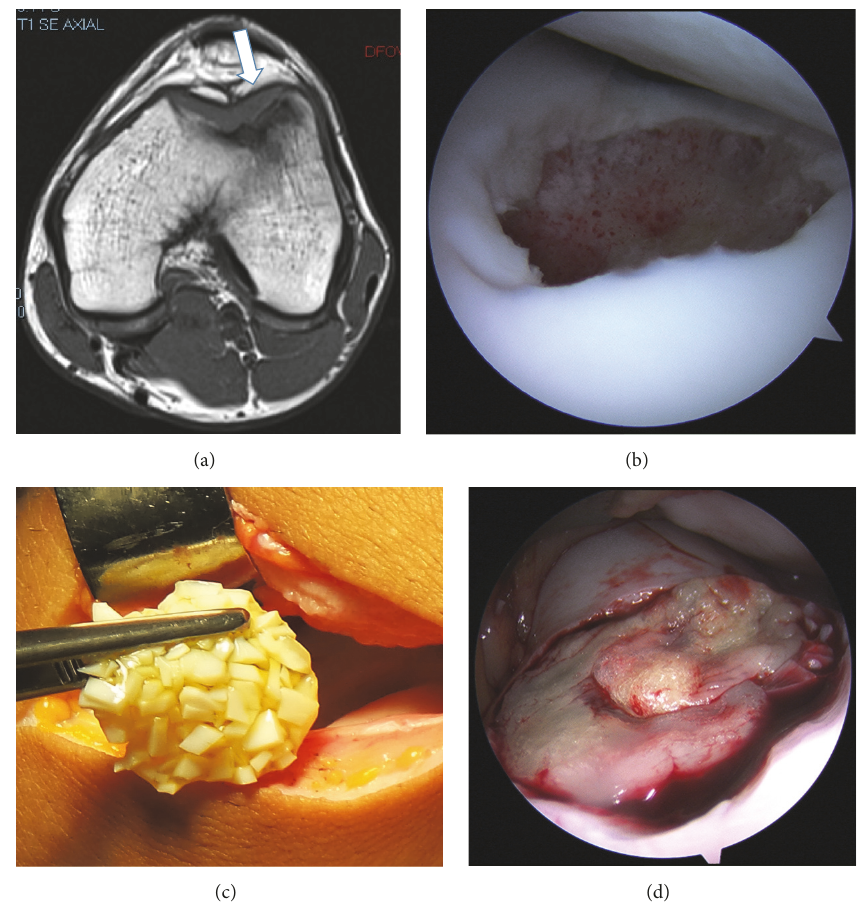
Figure 1: Composition of figures demonstrating the initial injury and surgical treatment. (a) Preoperative axial T1-sequence MRI demonstrating the osteochondral injury (white arrow). (b) Intraoperative picture demonstrating the debrided defect in the lateral femoral condyle. (c) Intraoperative picture demonstrating the autologous matrix before implantation. (d) Arthroscopic view of the filled defect at the end of the